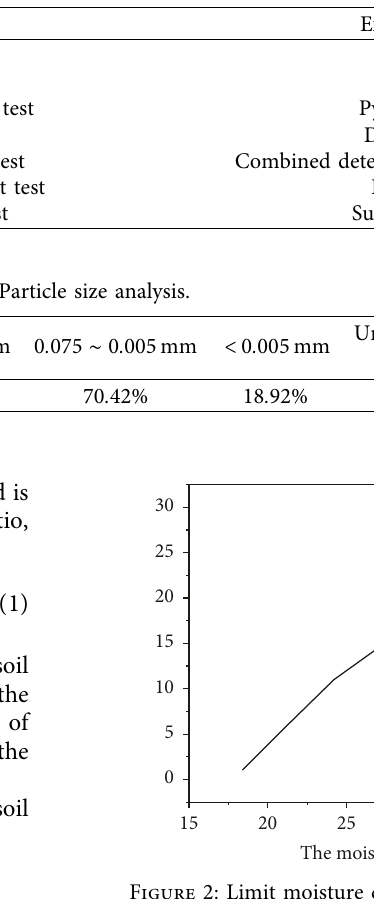
Table 1: Test methods used in various tests.